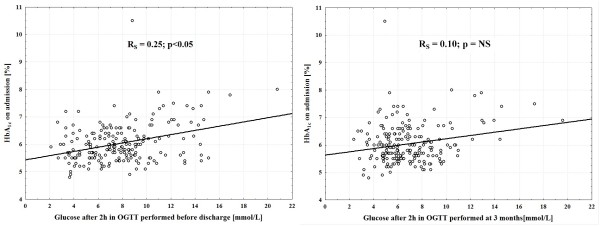
Relations between HbA1c assessed on admission and plasma glucose after 2 hours in OGTT performed before discharge and at 3 months, respectively. HbA1c - glycated hemoglobin; OGTT - oral glucose tolerance test; RS - the Spearman's rank correlation coefficient.